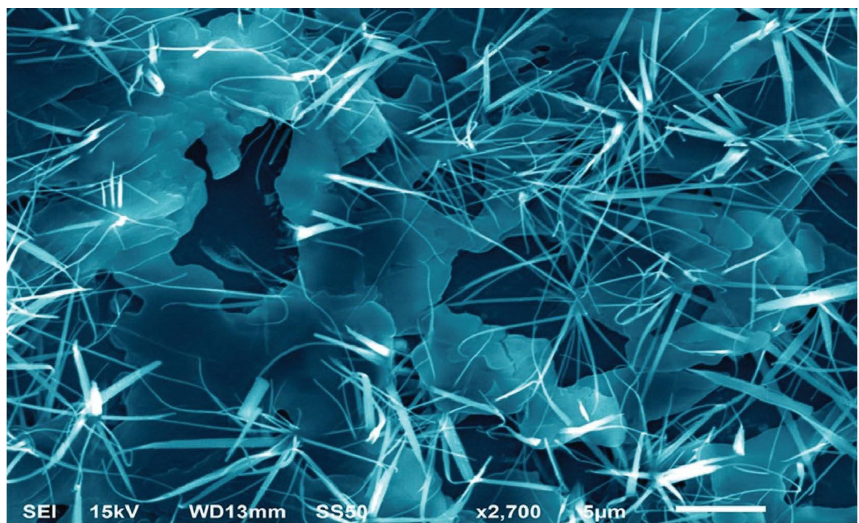
Figure 3: SEM photograph of synthesized G-ZnO NPs via the sol-gel process.